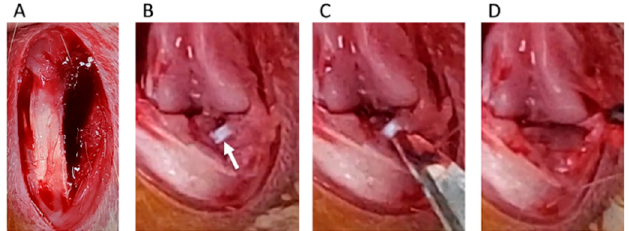
Figure 2. Surgical procedure of destabilization of the medial meniscus (DMM). ( A ) The medial edge of the patella tendon and the medial joint capsule are separated. ( B ) The medial meniscotibial ligament (MMTL) is detected. White arrow indicates the MMTL. ( C ) The MMTL is transected, and the medial meniscotibial joint capsule is horizontally cut. ( D ) Meniscal extrusion is confirmed.